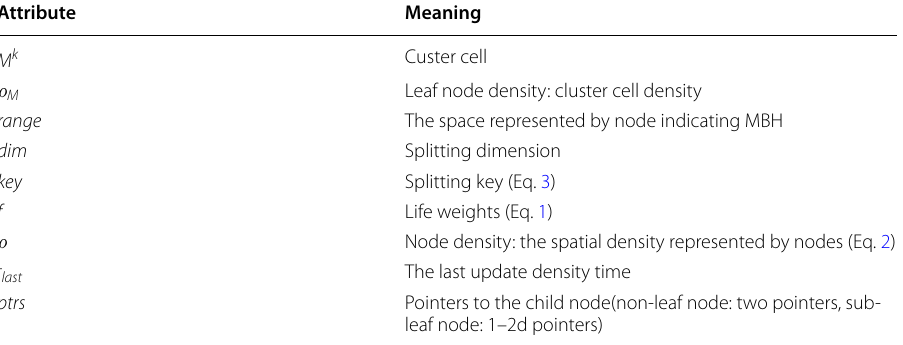
Table 1 Attributes of various nodes in the SKDTree Attribute Meaning M k Custer cell ρ M Leaf node density: cluster cell density range The space represented by node indicating MBH dim Splitting dimension key Splitting key (Eq.